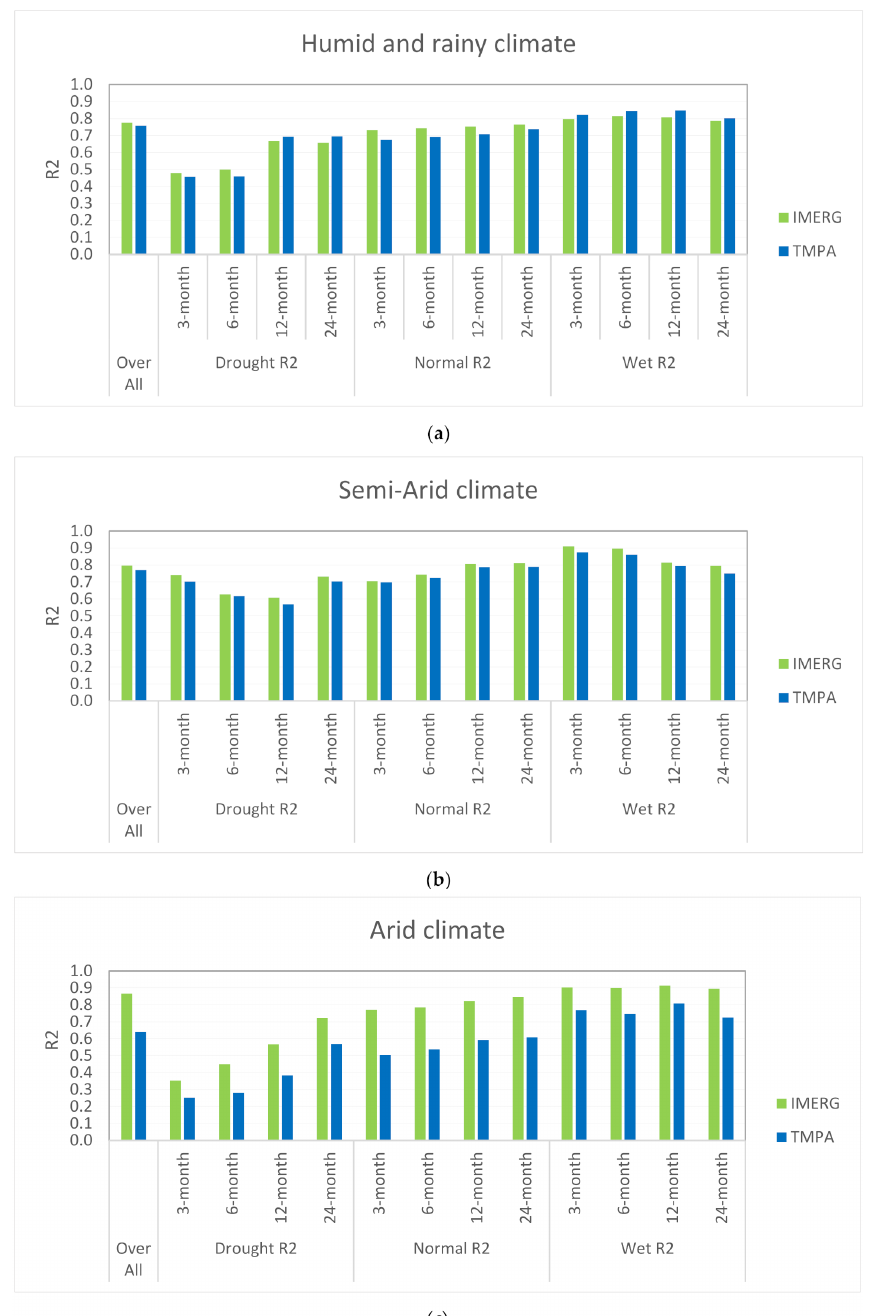
Figure 9. Comparison of average performance of satellite product in wet, normal, and drought periods of ( a ) humid and rainy, ( b ) semi-arid, and ( c ) arid